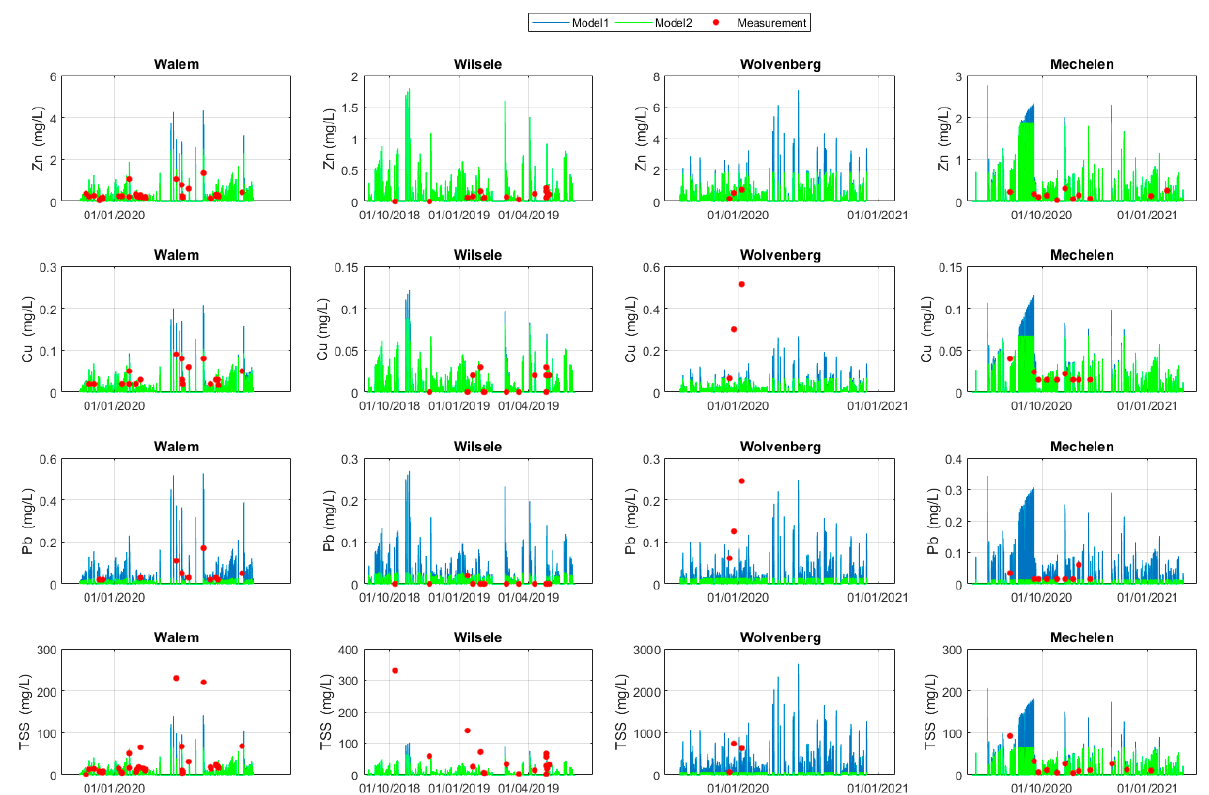
Figure 4. Detail of the modelled Zn concentrations in Walem.